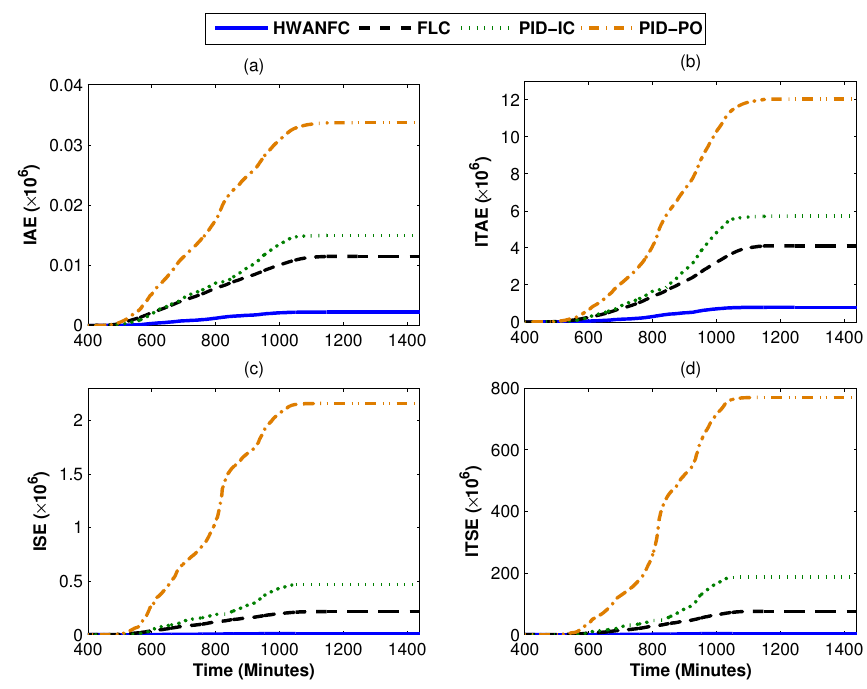
Figure 9. Dynamic performance indexes: ( a ) Integral Absolute Error (IAE); ( b ) Integral Time Absolute Error (ITAE); ( c ) Integral Square Error (ISE); ( d ) Integral Time Square Error